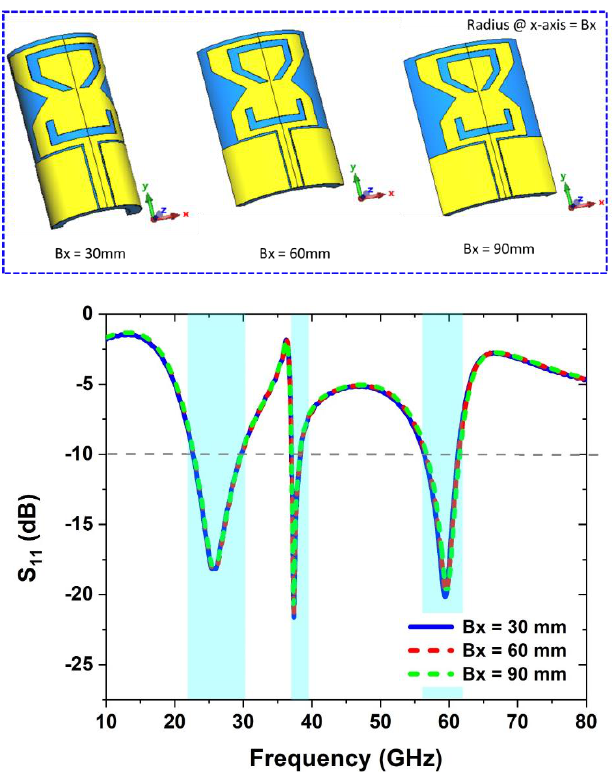
Figure 5. Antenna bending analysis along x -axis.